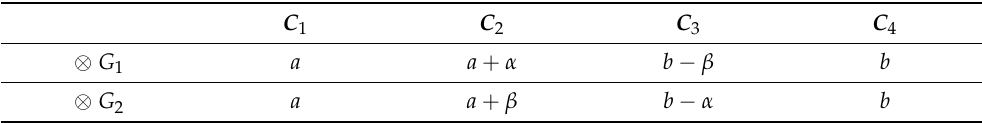
Table 4. The GEP